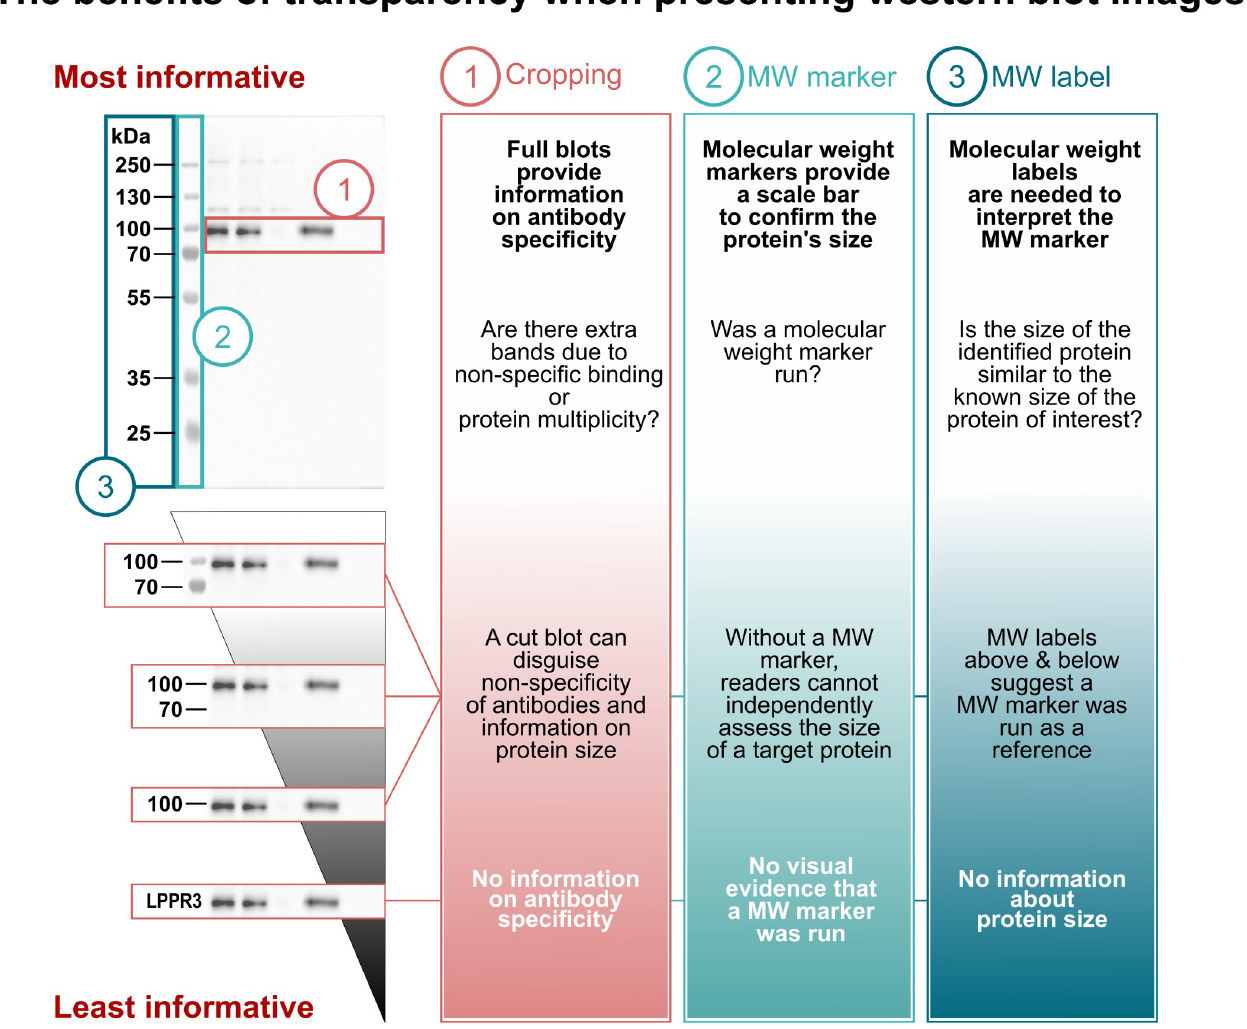
Fig 2. More and less informative western blot image display practices. Readers need 3 pieces of visual information to assess western blot results. Suboptimal image display practices can omit this information. (1) Extra bands indicate that the antibody may not be specific to the protein of interest or may recognize multiple forms of the protein of interest. Cropped blots omit this information. (2) Molecular weight (MW) markers allow readers to confirm that protein size was determined using known standards. (3) MW labels show protein sizes, in kDa, for each MW marker band. Displaying the MW marker and labelling MW marker bands above and below the protein of interest is more informative than labelling only the protein of interest. For the unprocessed image, see S1